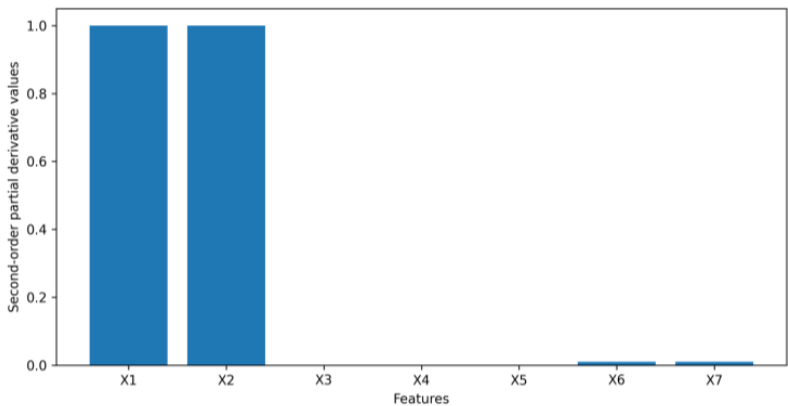
Figure 8. Feature interaction for simulated data.